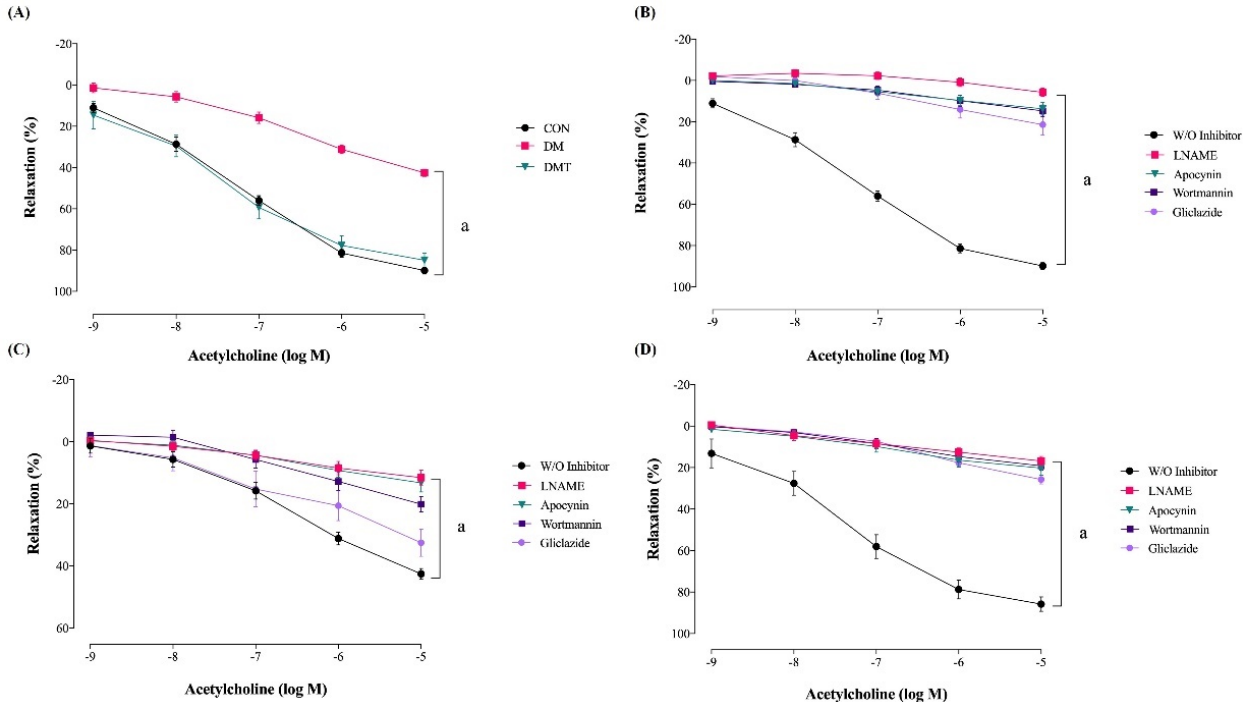
Figure 2. ( A ) Concentration response curves to acetylcholine in the aorta of the experimental rats. Concentration response curves to acetylcholine in the presence of pharmacological inhibitors in the aorta of ( B ) CON rats, ( C ) DM rats, and ( D ) DMT rats (n = 9). Relaxations are expressed as the per- centage of the contraction induced by phenylephrine. Abbreviation: CON; Control, DM; Diabetes, DMT; Diabetes receiving TUDCA, LNAME; L-Nitro-Arginine Methyl Ester, and W/O; without in- hibitor. Table 1. Percentage of maximal relaxations to acetylcholine in the rat